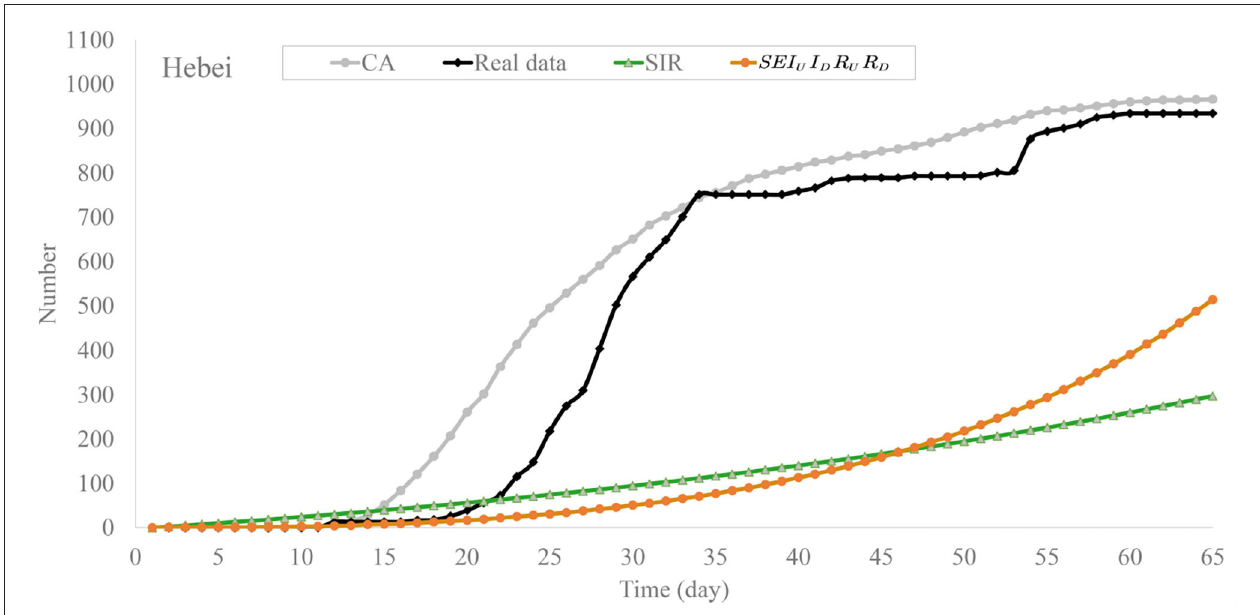
FIGURE 9 | Trend chart of recovered cases of the models in Hebei province.